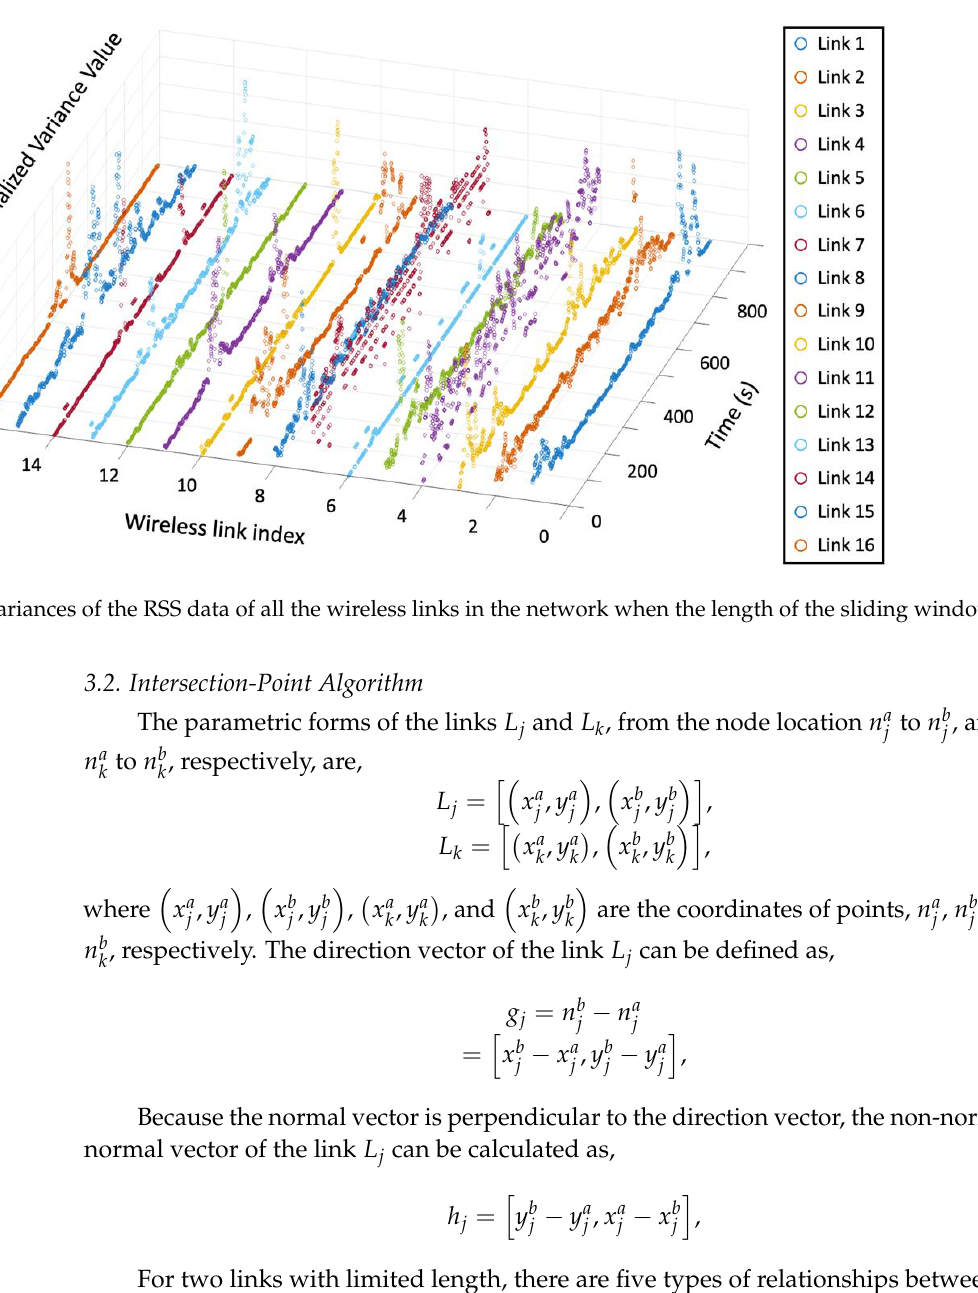
Figure 2. Raw received-signal strength (RSS) data of all the wireless links in the network.